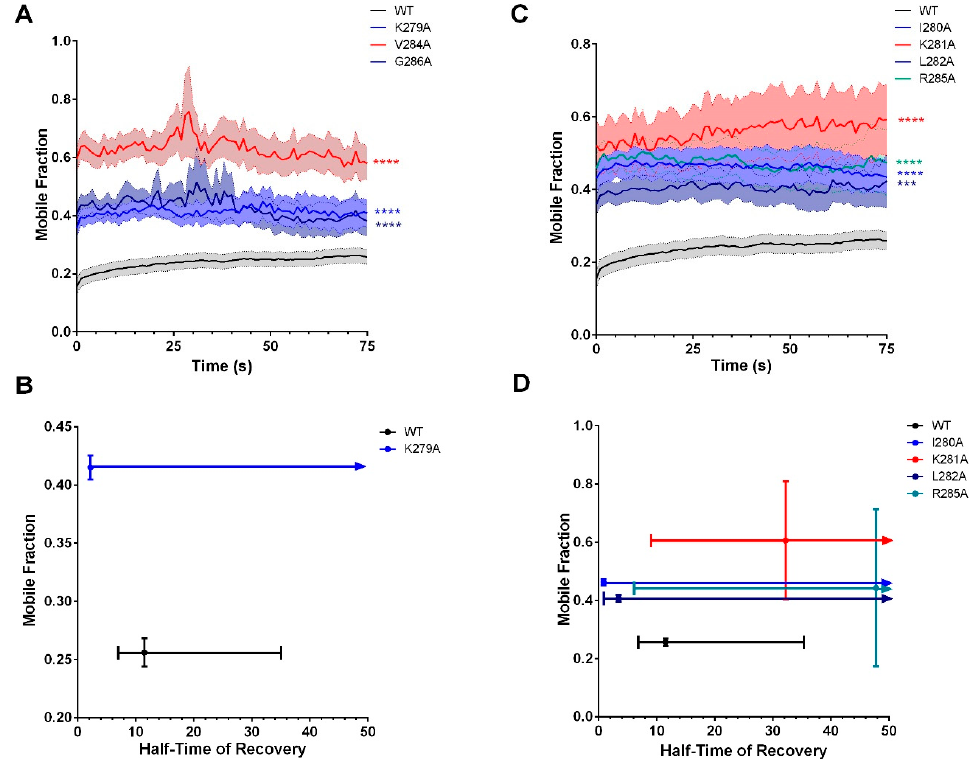
Figure 11. Recovery of Cx36 at the GJP was impaired after targeting individual amino acids within the tubulin-binding motif. Repopulation of connexons at the gap-junction plaque was significantly impaired in all mutants targeted in the site-directed alanine scan of the tubulin-binding motif. ( A , B ) Recovery plot and corresponding XY scatterplot illustrating the relationship between the mobile fraction (%) and half-time of recovery (s) of the residues conserved between Cx36 and Cx43 in the tubulin-binding motif. Recovery curves are the mean ± SEM and mean ± CI for the XY plots of mobile fraction against half-time of recovery. Sample sizes ( n ) were n = 28 for the WT, n = 10 for K279A, n = 19 for V284A, and n = 14 for G286A GJPs. **** p < 0.0001, Kruskal–Wallis test; all samples were compared to the wild-type control. Please note curve fitting for V284A and G286A was not possible; therefore, neither are diagramed here. ( C , D ) Recovery plot and corresponding M f vs. T 1 / 2 plot non-conserved residues. Since curve fitting was unsuccessful for Cx36-R285A, it was not reported in the M f vs. T 1 / 2 scatterplot. Deviations in the M f and T 1 / 2 suggest that alternations to the tubulin-binding motif were su ffi cient to provoke phenotypes similar to the complete ablation of the tubulin-binding motif. Recovery curves are the mean ± SEM and mean ± CI for the XY plots of mobile fraction against half-time of recovery. Sample sizes ( n ) were n = 28 for the WT, n = 20 for I280A, n = 15 K281A, n = 23 for L282A, and n = 22 for R285A GJPs. *** p < 0.001, **** p < 0.0001, Kruskal–Wallis test; all samples were compared to the wild-type